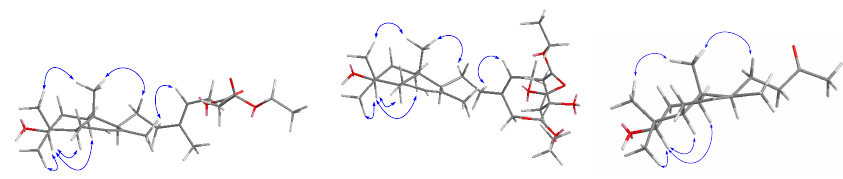
Figure 3. Key NOESY correlations of compounds 1 – 3 .